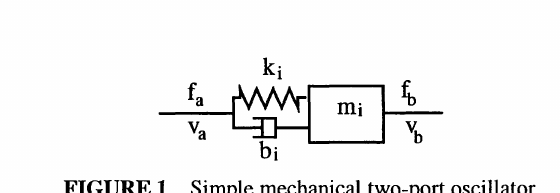
FIGURE 1 Simple mechanical two-port